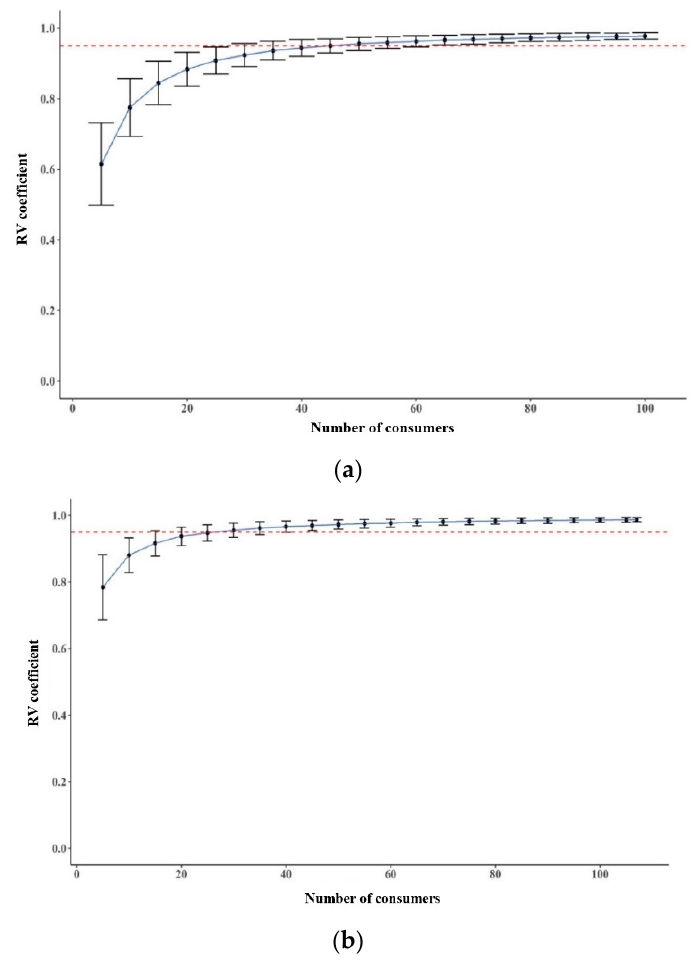
Figure 2. Dendrograms from agglomerative hierarchical cluster analysis performed on yakju samples for ( a ) CATA method, ( b ) RATA method, and ( c ) CATA-JAR method. Product codes as in Table 1.